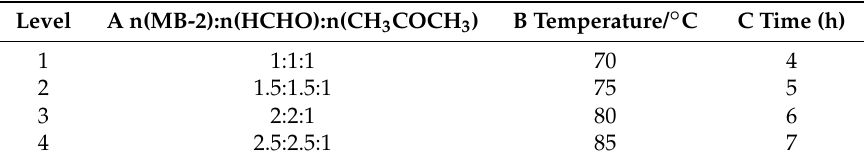
Table 1. Experimental factors and levels.